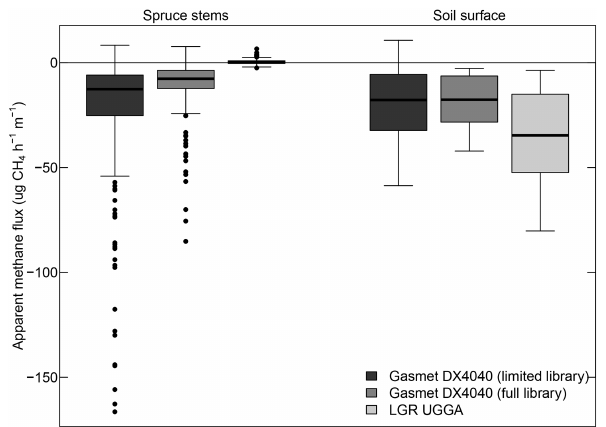
Figure 1. Apparent tree stem methane fluxes when quantified with a laser-spectroscopy-based analyser (LGR UGGA) and a FTIR-based analyser (Gasmet DX4040). FTIR-based fluxes are shown calcu- lated based on spectral deconvolution with a minimal library that did not contain VOC spectra (limited library) and with a library that contained spectra of commonly occurring VOCs (full